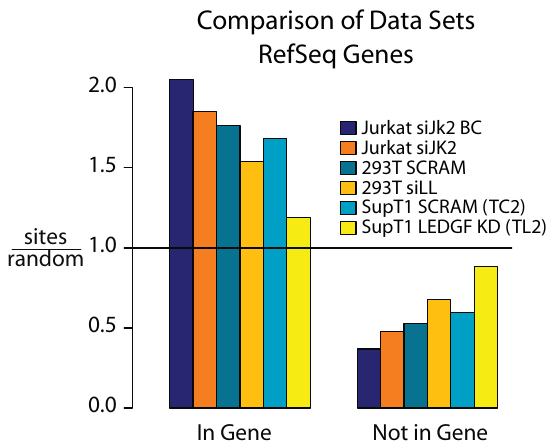
Figure 5. Comparison of LEDGF/p75 knockdowns in different human cell types. The Jurkat and 293T data sets are described in detail in [40]. Integration frequency was compared within RefSeq genes.